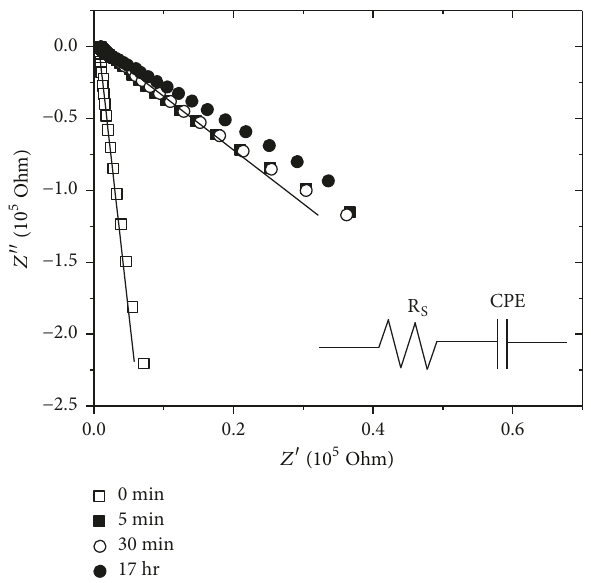
Figure 2: EIS data for a PMPMS layer crosslinked with BMDPM for the indicated time. Calculated fits, using an equivalent circuit of a solution resistance in series with a constant phase element, are shown for the 0 and 30 min data series as solid